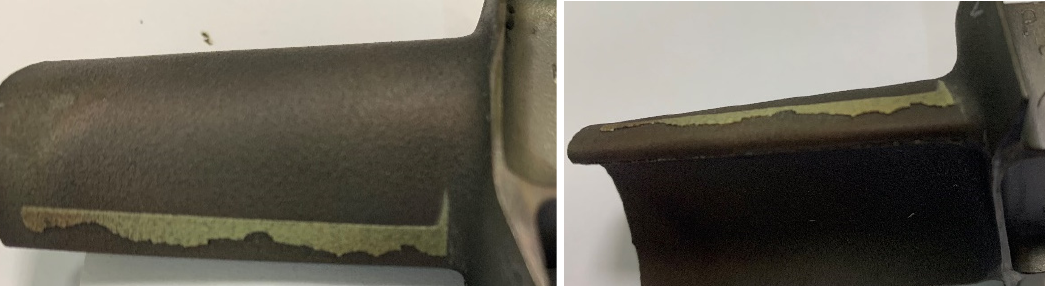
Figure 9. Macrophotographs of the leading edge of the blade with a protective coating made by the APS + TBC method.